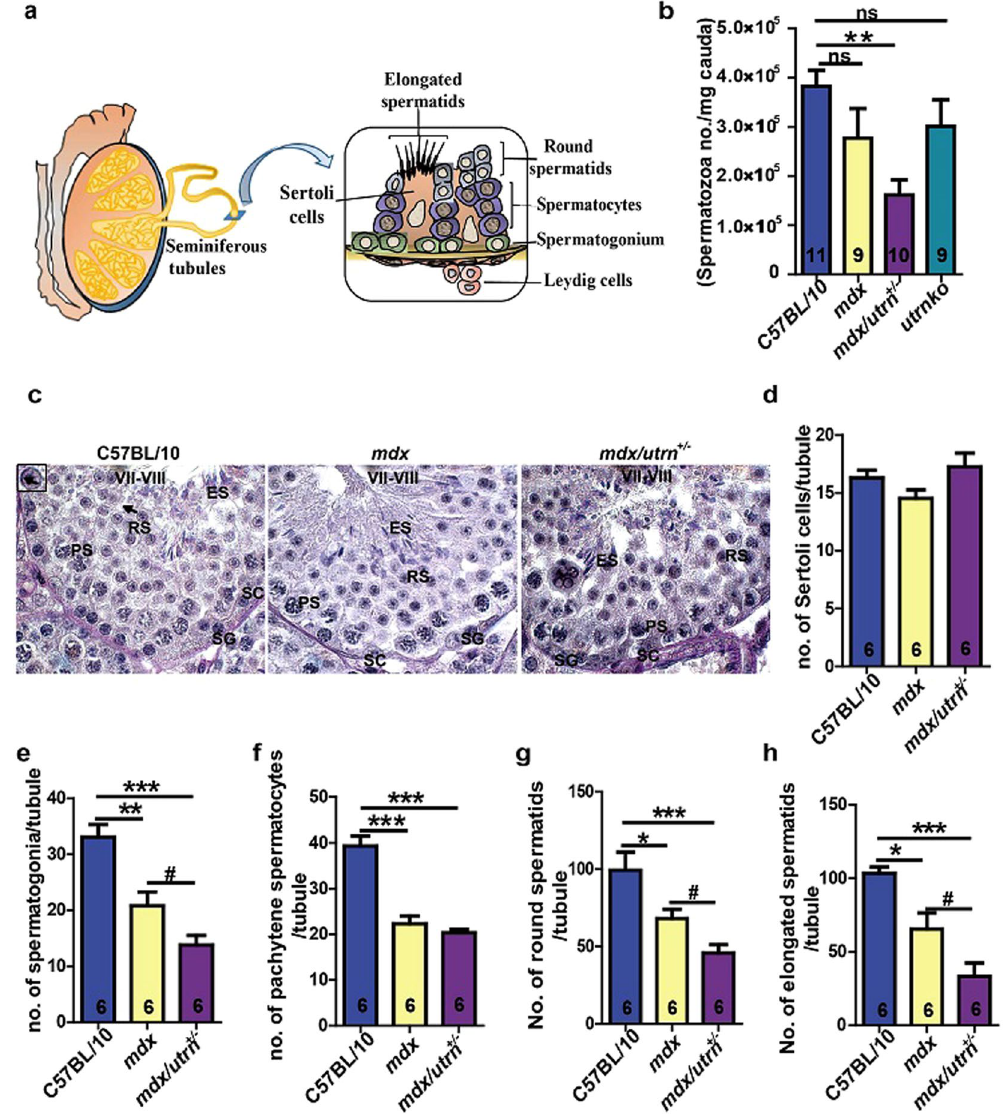
Figure 6. Deficiency of dystrophin/utrophin causes reduction of spermatogenic cells. ( a ) Schematic illustration of the structure of the seminiferous tubule which contains supporting Sertoli and Leydig cells, spermatogonia, spermatocytes, round spermatids and elongated spermatids. ( b ) The spermatozoa density of cauda epididymidis in C57BL/10, mdx , mdx/utrn + / − and utrnko mice. ( c ) The cross sections of the ten-week-old mouse testes were stained with PAS to classify germ cells of different stages. The arrows and inset in the first panel show the representative PAS staining of a round spermatid. ( d ) The number of Sertoli cells per seminiferous tubule in C57BL/10, mdx and mdx/utrn + / − testes. ( e ) The number of spermatogonia per seminiferous tubule in C57BL/10, mdx and mdx/utrn + / − testes. ( f ) The number of pachytene spermatocytes per seminiferous tubule in C57BL/10, mdx and max/utrn + / − testes. ( g ) The number of round spermatids per seminiferous tubule in C57BL/10, mdx and mdx/utrn + / − testes. ( h ) the number of elongated spermatids per seminiferous tubule in C57BL/10, mdx and mdx/utrn + / − testes. Data were analyzed with one-way ANOVA. All values are represented as mean ± SEM. * compared with the C57BL/10; # compared with the mdx . # P < 0.05; * P < 0.05; ** P < 0.01; *** P < 0.001. SC, Sertoli cells; SG, spermatogonium; PL, preleptotene spermatocyte; PS, pachytene spermatocyte; RS, round spermatid; ES, elongated spermatid. PAS: Periodic acid–Schiff stain; ns: not significant. Scale bar: 20 μ